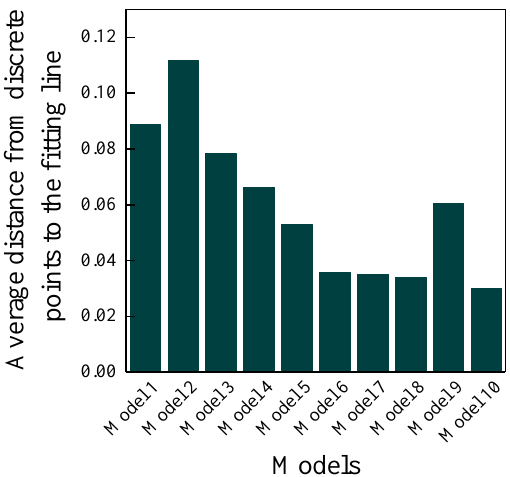
Figure 5. The average distance from discrete points to the line provided by the models in Figures 3 and 4.